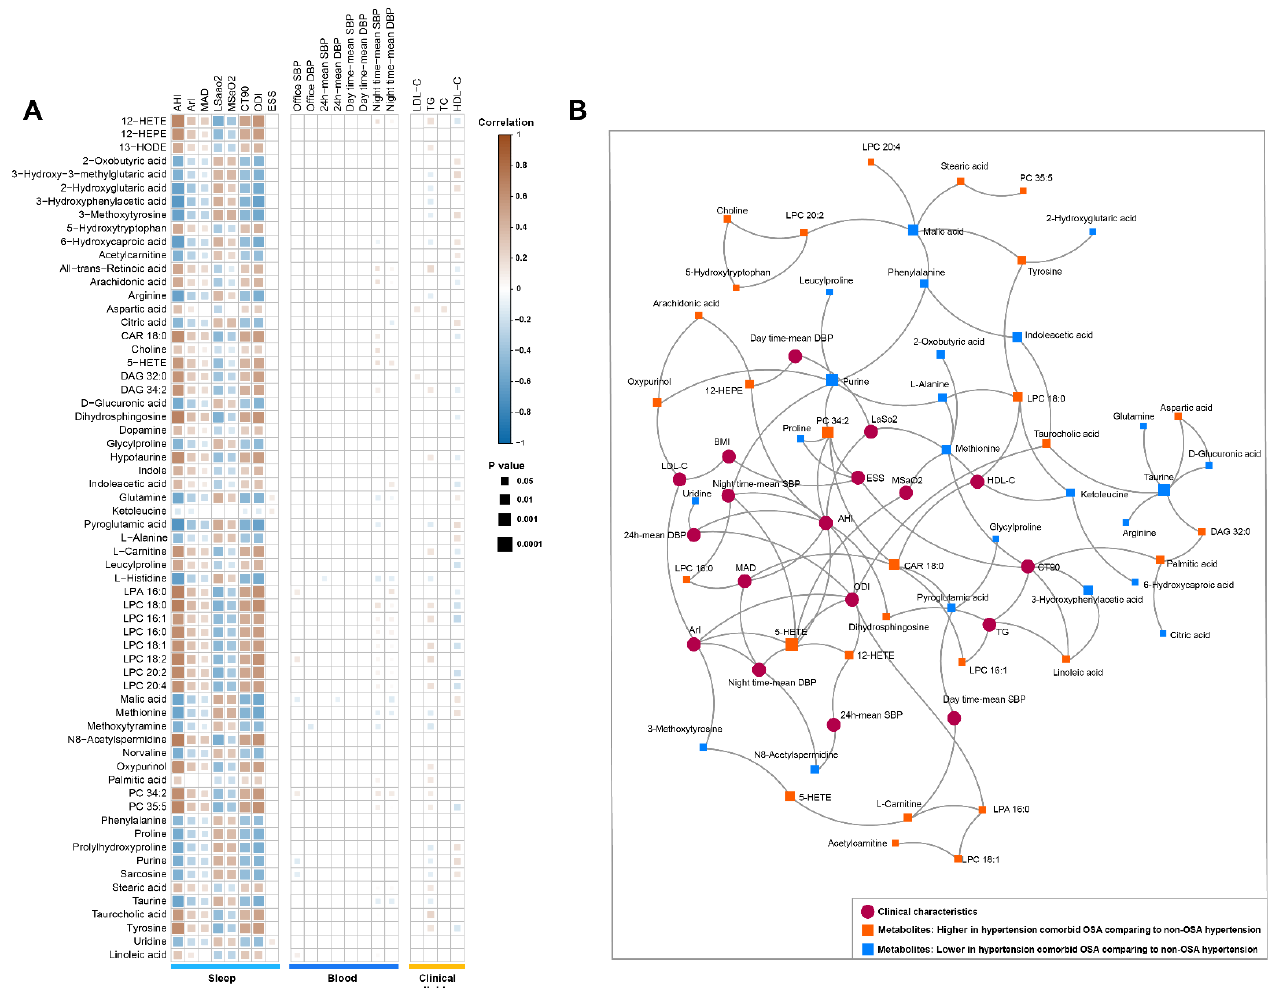
Figure 5. Correlation network of metabolic signatures and cli87nical variables. ( A ) Spearman’s rank correlation plot depicting the association of each differentiated metabolite with sleep measures, blood pressures, and clinical lipids. Positive correlations are displayed in orange and negative correlations in blue. Color intensity and size of the square are proportional to the Spearman correlation coefficients. Only metabolites with p < 0.05 are depicted with square labels. ( B ) Debiased sparse partial correlation network plot visualizing the major relationships of key metabolites and clinical variables; squares represent metabolites, circles represent clinical variables, the solid lines indicate significant correlation with a |coefficients| > 0.5.